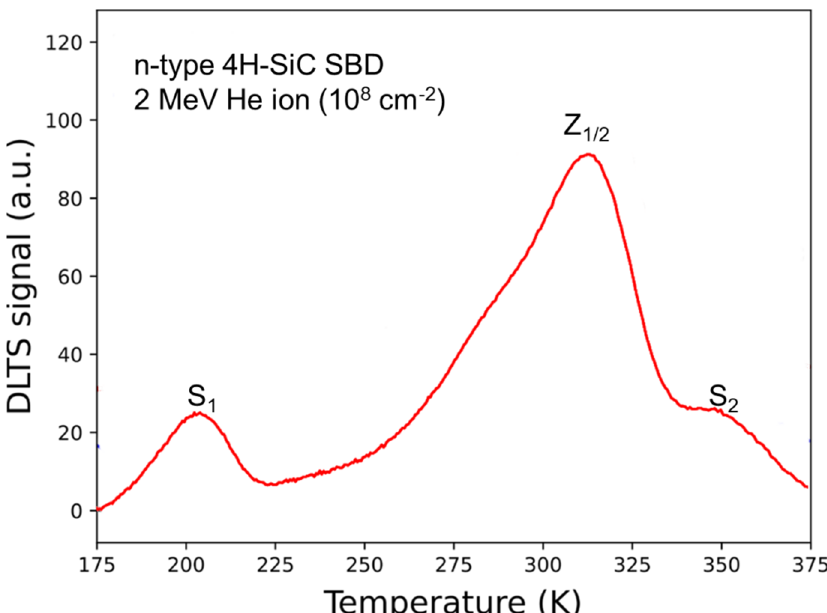
Figure 6. DLTS spectrum for 2 MeV He ion-implanted n-type 4H-SiC SBD. Several deep level defects are observed: S 1 , Z 1/2 , and S 2 . Data adapted from Ref. [16].